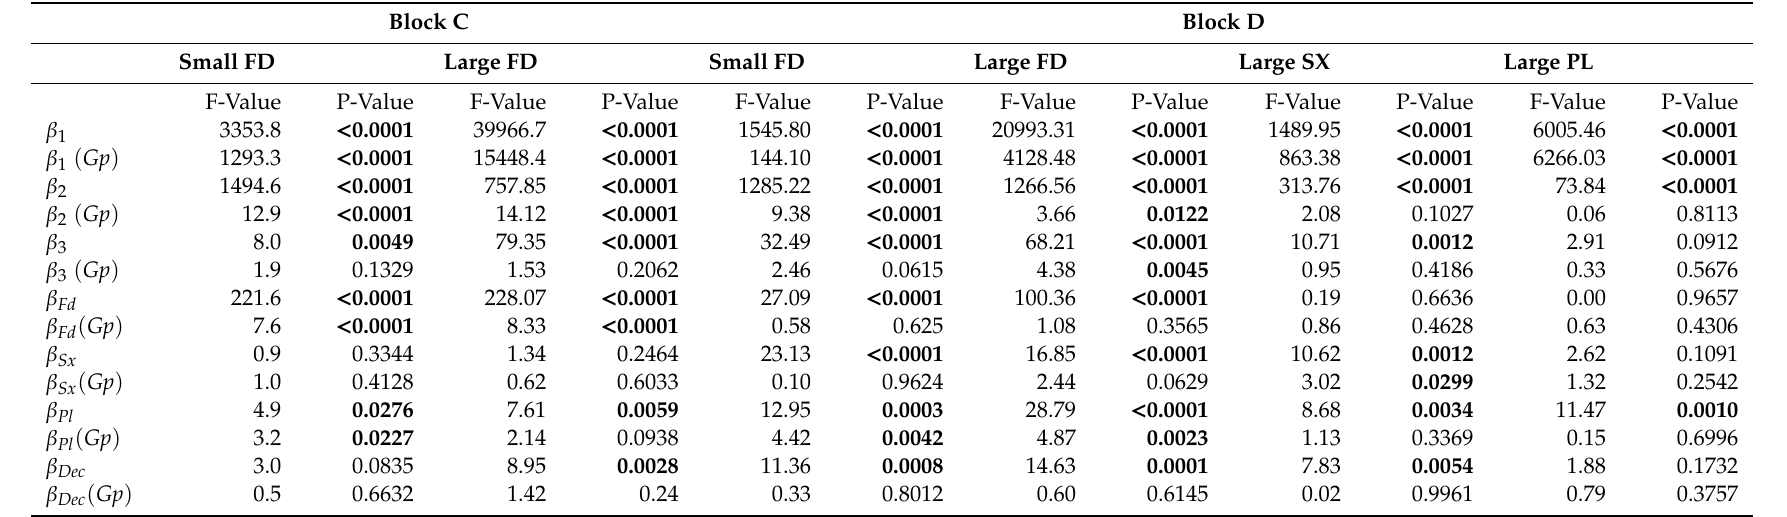
Table 6. F tests for the significance of the fixed e ff ects estimated for the partitioned competition index (Equation (9)) for Blocks C and D. The fixed e ff ect parameter estimates are presented in Table 5. Degrees of freedom for the numerator and denominator of the F test statistic are 1, 3, and 1489 for Small FD in Block C; 1,3, and 1085 for Large FD in Block C; and 1, 3, and 1265 for Small FD; 1, 3, and 1017 for Large FD; 1, 3, and 336 for Large SX; and 1 and 97 for Large PL in Block